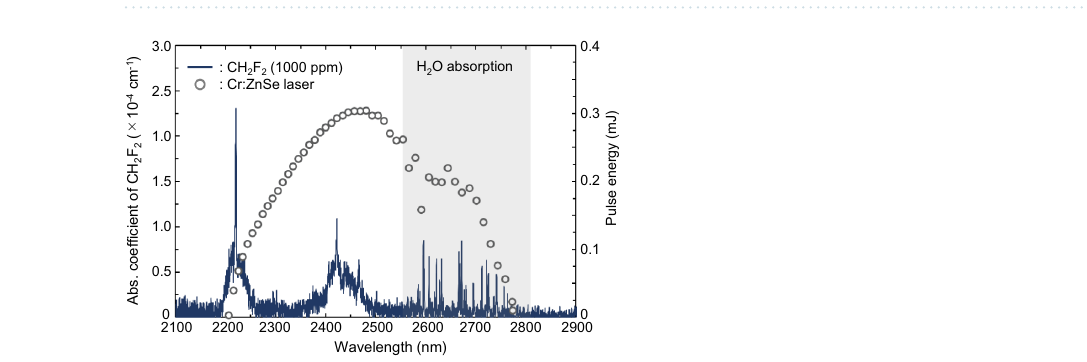
Figure 2. Output performances of the ET-Cr:ZnSe laser. ( a ) Wavelength tuning range and filter tuning curve of the AOTF. ( b ) Output optical spectra of the ET-Cr:ZnSe laser. ( c ) Temporal and spatial profiles at 2.4 µm. ( d ) Pulse width as a function of wavelength.